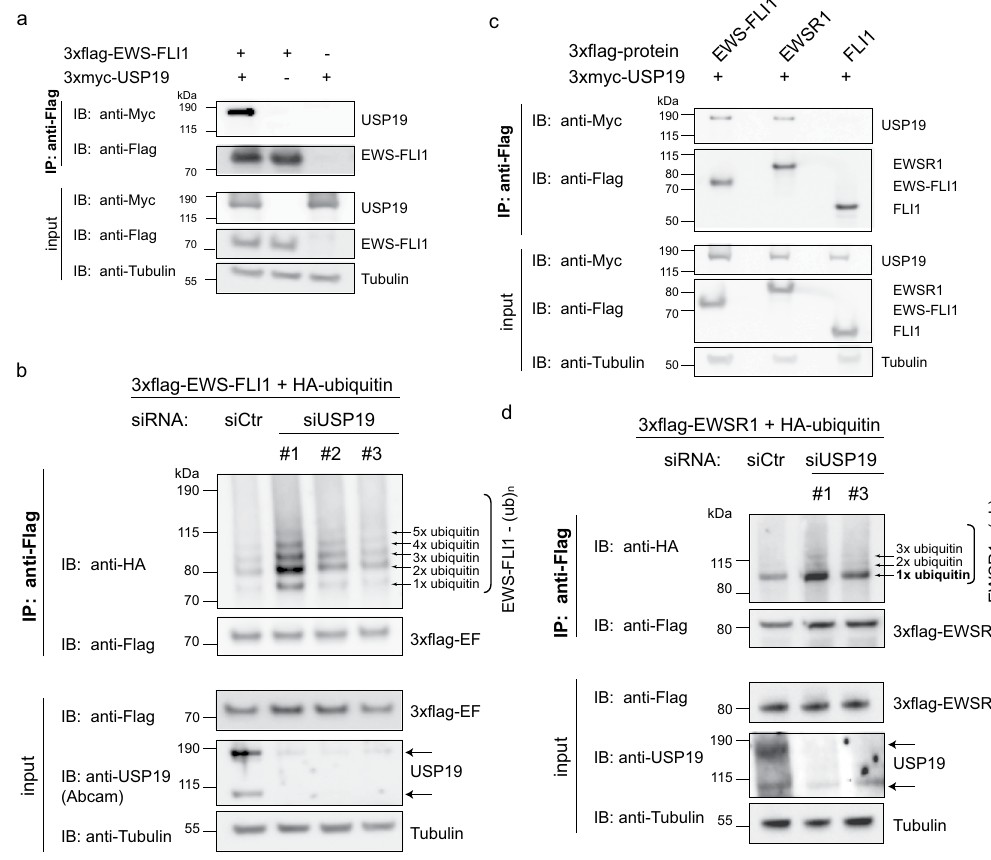
Figure 3. EWS-FLI1 ubiquitination is modulated by USP19. ( a ) EWS-FLI1 interacts with USP19. 3xflag-EWS- FLI1 and 3xmyc-USP19 were co-expressed in HEK293T cells for 48 h. After co-immunoprecipitation, lysates were analyzed by western blotting as indicated. ( b ) USP19 depletion increases EWS-FLI1 ubiquitination. A673 cells were transiently incubated with three different siRNAs against USP19 or a control siRNA for 24 h followed by co-expression of 3xflag-EWS-FLI1 and HA-ubiquitin for 48 h. Ubiquitination of EWS-FLI1 was analyzed by western blot analysis using anti-HA antibody. ( c ) EWSR1 also immunoprecipitates with USP19. 3xflag-EWS-FLI1, 3xflag-EWSR1 or 3xflag-FLI1 were co-expressed with 3xmyc-USP19 in HEK293 cells for 48 h. After co-immunoprecipitation, lysates were analyzed by western blotting as indicated. ( d ) USP19 depletion increases EWSR1 monoubiquitination. A673 cells were transiently incubated with two different siRNAs against USP19 or a control siRNA for 24 h followed by co-expression of 3xflag-EWSR1 and HA-ubiquitin for 48 h. Ubiquitination of EWSR1 was analyzed by western blot analysis using anti-HA antibody. Full-length blots of all immunoprecipitates are presented in Supplementary Fig.